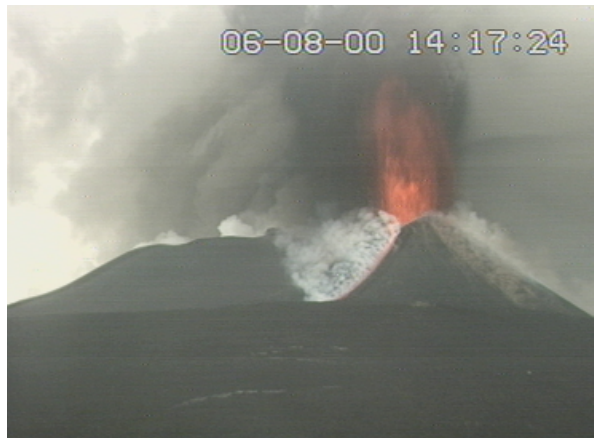
Fig. 1. Fire-fountain activity at the South-East crater of Mt. Etna on 8 June 2000. Horizontal edge of photo ∼ 700m. Courtesy of D.